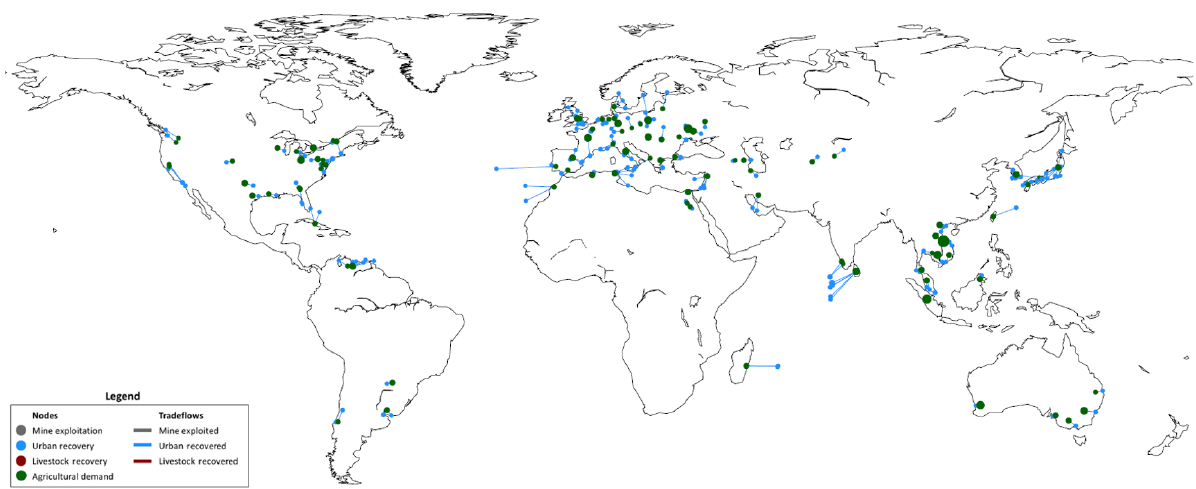
Figure 5. Phosphorus trade network for trade in both conventional and recycled P (scenario 2) but showing only sustainable trade flows. Optimal trade occurs at a phosphorus market price of 2039USDt − 1 with 16.81Mt being traded in total, of which 0.15Mt is traded sustainably (0.8% of total